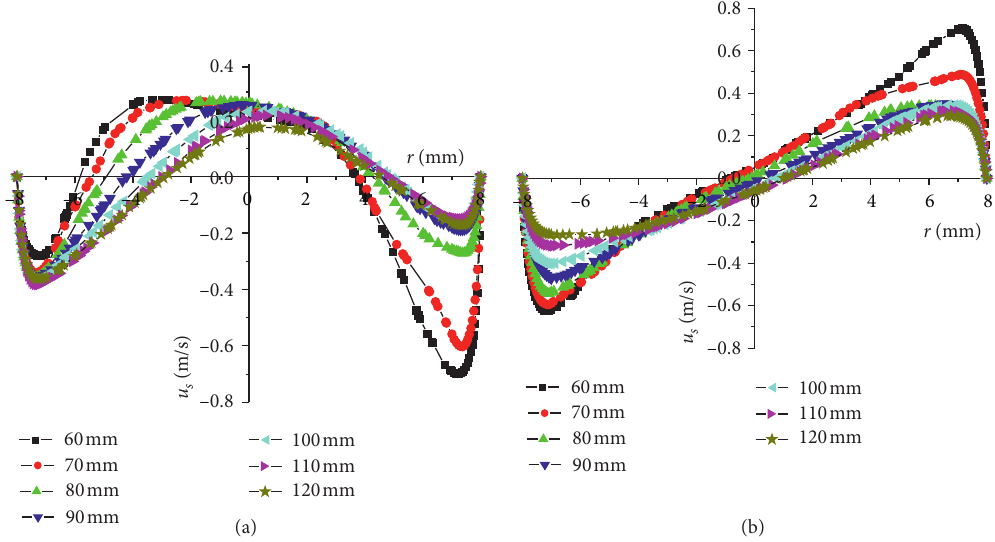
Figure 15: Axial velocity distribution of Y 3 sections at different cylinder lengths. (a) Axial speed. (b) Tangential speed.